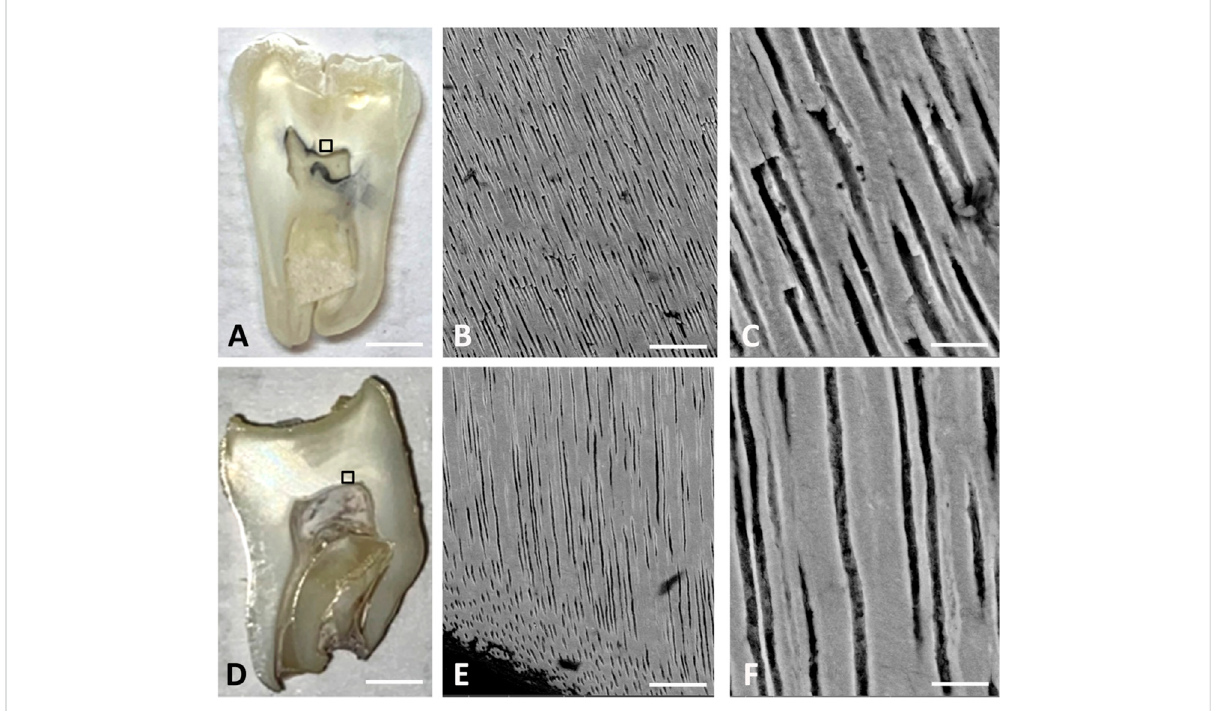
FIGURE 5 Scanning electronic microscopy. (A) Optical image of sound teeth/control; scale bar: 3 mm; (B) SEM image of sound dentin; scale bar: 50 μ m (C) zoom on sound dentin; scale bar: 10 μ m; (D) ERS4 optical image scale bar: 3 mm; (E) SEM image of ERS4 dentin; scale bar = 50 μ m; (F) zoom on ERS4 dentin; scale bar = 10 μ